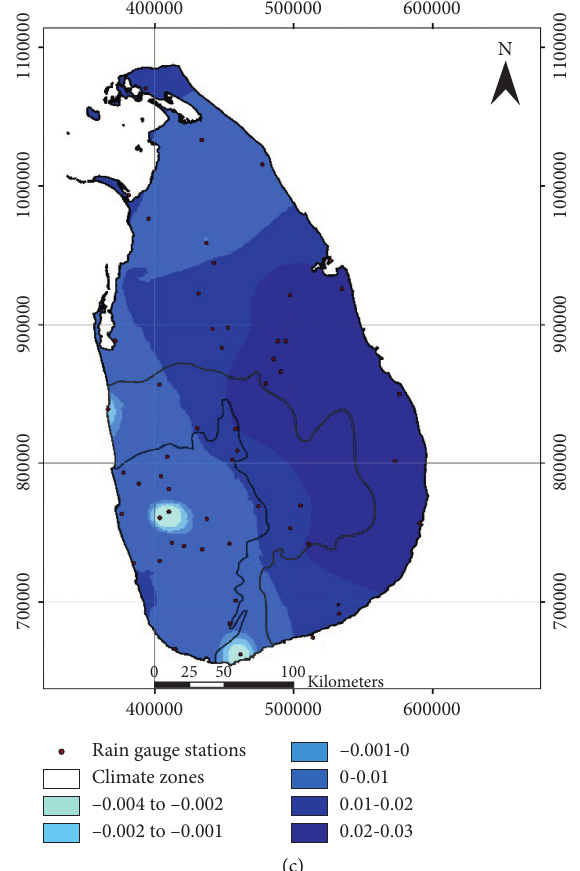
Figure 7: Drought trend over Sri Lanka in terms of the Sens’ slope of SPI. (a) Annual; (b) Yala ; and (c) Maha